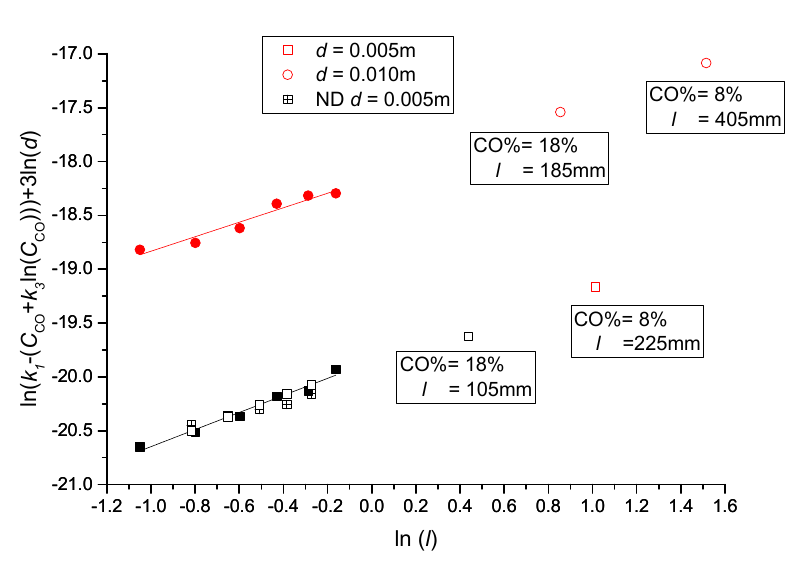
Figure 12. Fitting line of the H 2